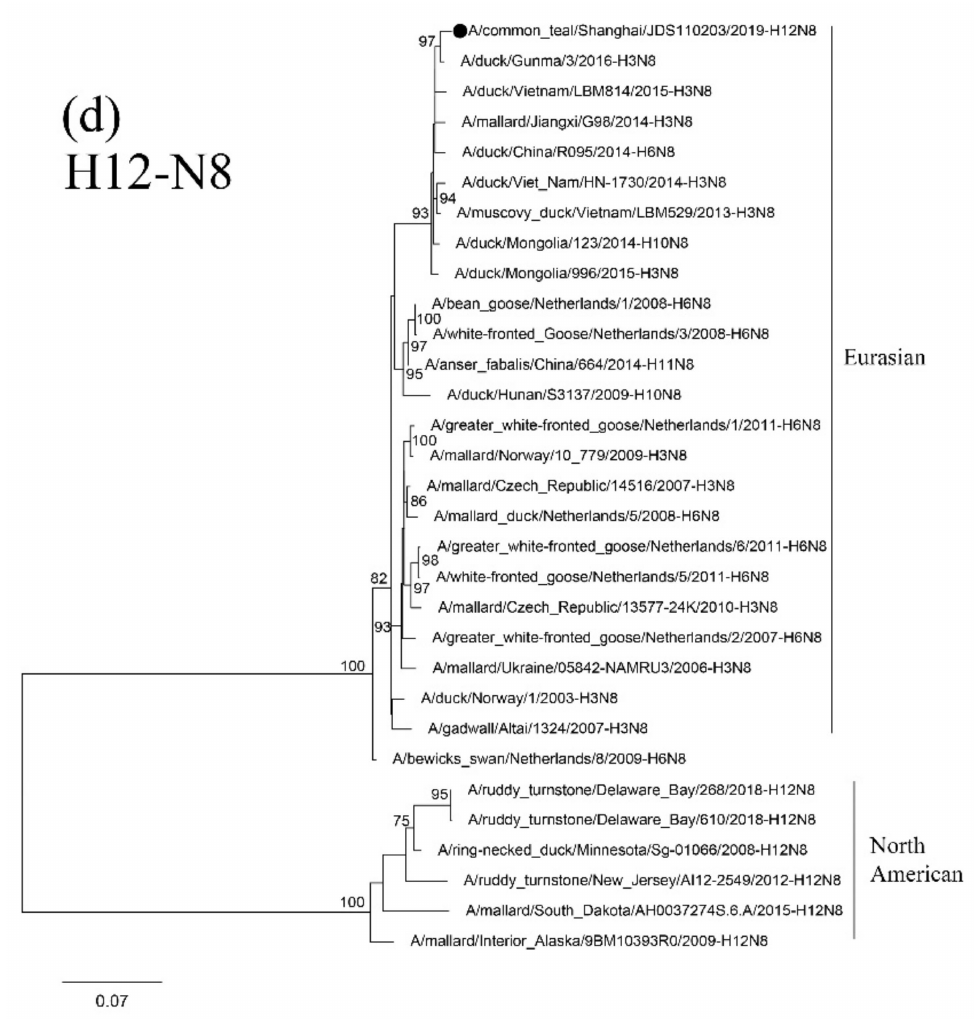
Figure 4. Phylogenetic trees of HA ( a ), N2 ( b ), N5 ( c ), and N8( d ) genes of the H12 isolates found in Shanghai, China. HA, N2, N5 and N8 genes are 34–1704 bp, 24–1410 bp, 18–1399 bp and 24–1389 bp, respectively. The maximum-likelihood (ML) trees were constructed using the GTR + G model for HA, N5 and N8 genes and the TrN + I model for N2 genes in PhyML software version 3.0. Bootstrap values were calculated for 100 replicates. Values less than 75% are not shown. Numbers indicate ML bootstrap values. H12 AIV isolates characterized in this study are indicated with black